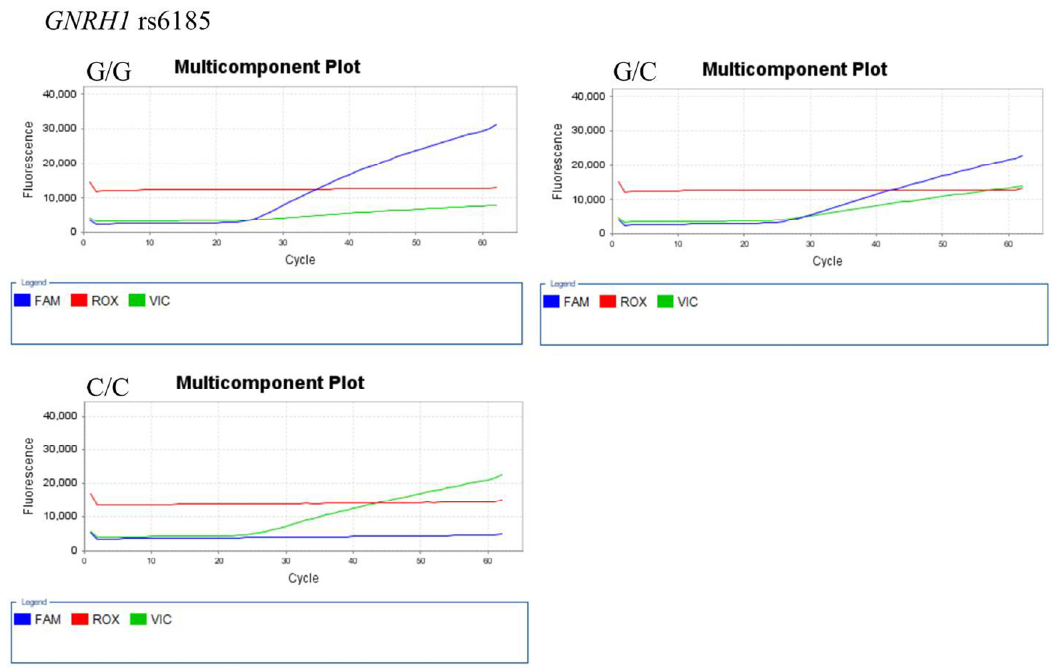
Figure 3. Representative TaqMan assay for GNRH1 (rs6185) genotyping. The FAM (blue) and VIC (green) fluorescence probes detect G and C alleles, respectively. The ROX (red) fluorescence probes is used for calibration.